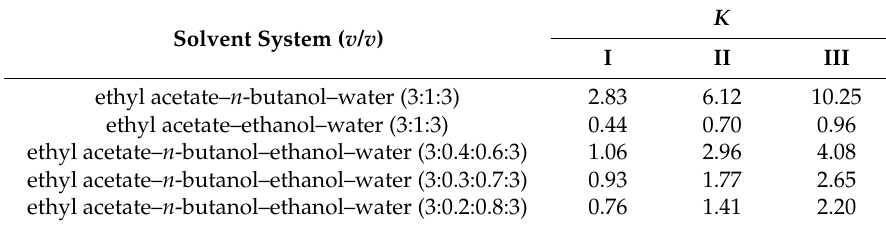
Table 1. The K -values of the target compounds in several solvent system. Solvent System ( v / v )